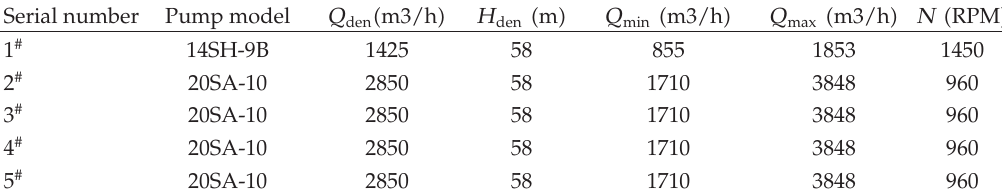
Table 1: The configuration and the parameters of the pump.